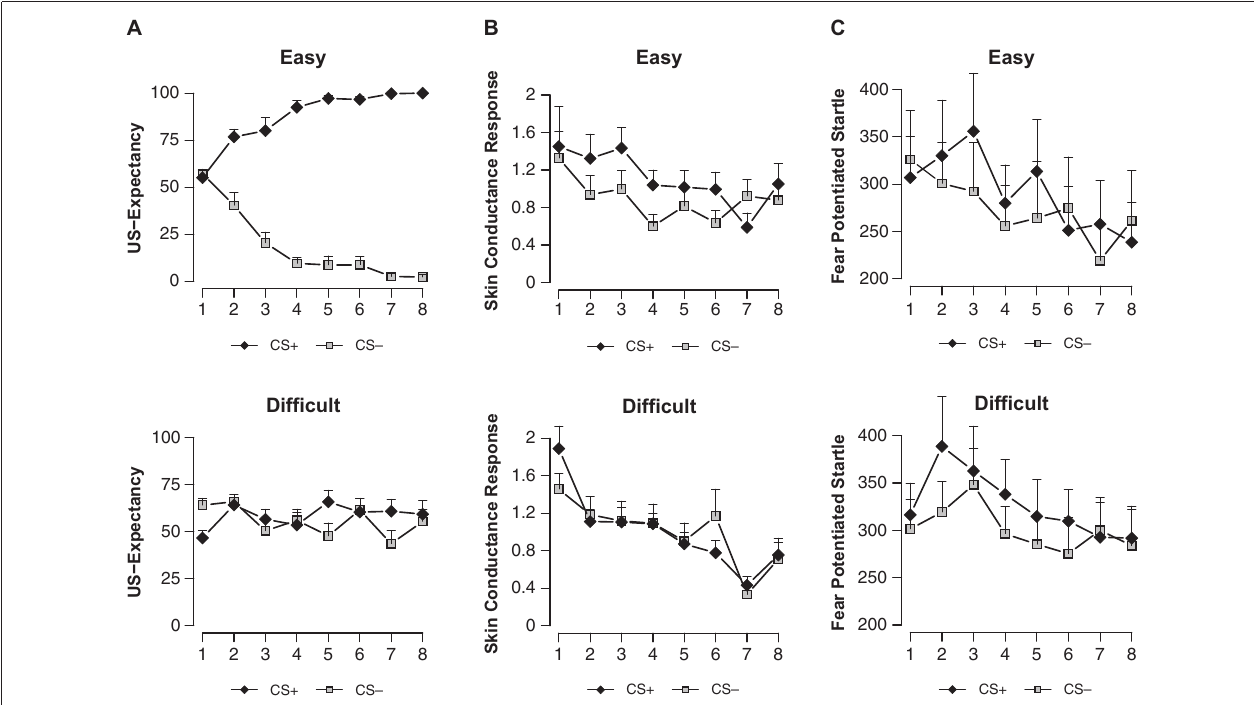
FIGURE 2 | US-expectancy ratings (A) , skin conductance responses (B) and startle responses (C) to the CS + and CS − for the Easy ( n = 16) and Difficult ( n = 18) conditions. Error bars represent